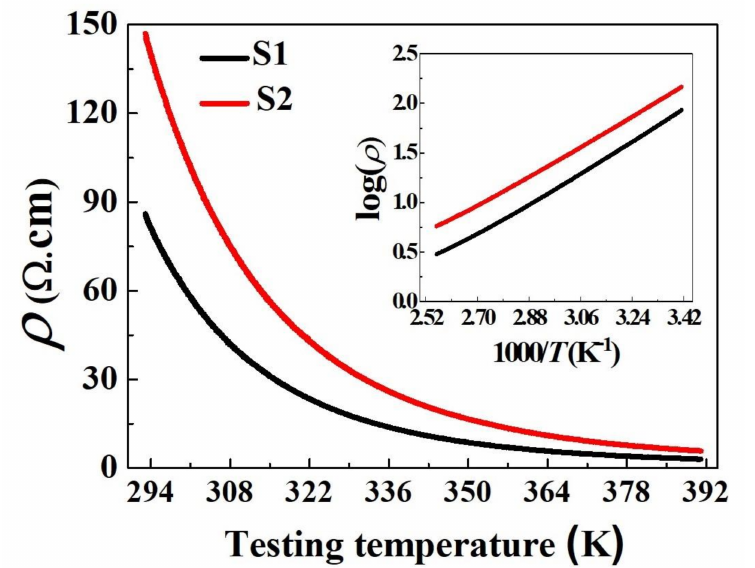
Figure 7. Resistivity − temperature ( ρ − T ) curve of sintered ceramics. The insert shows a plot of log( ρ ) versus (1000/ T ).